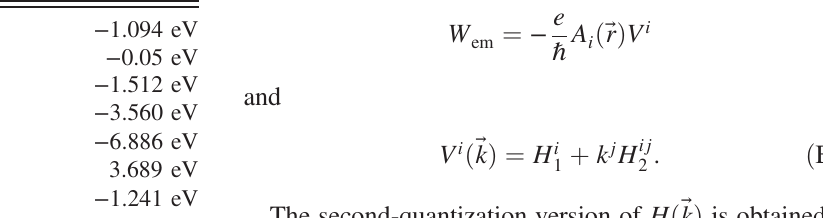
TABLE III. Tight-binding parameters employed in the MoS 2